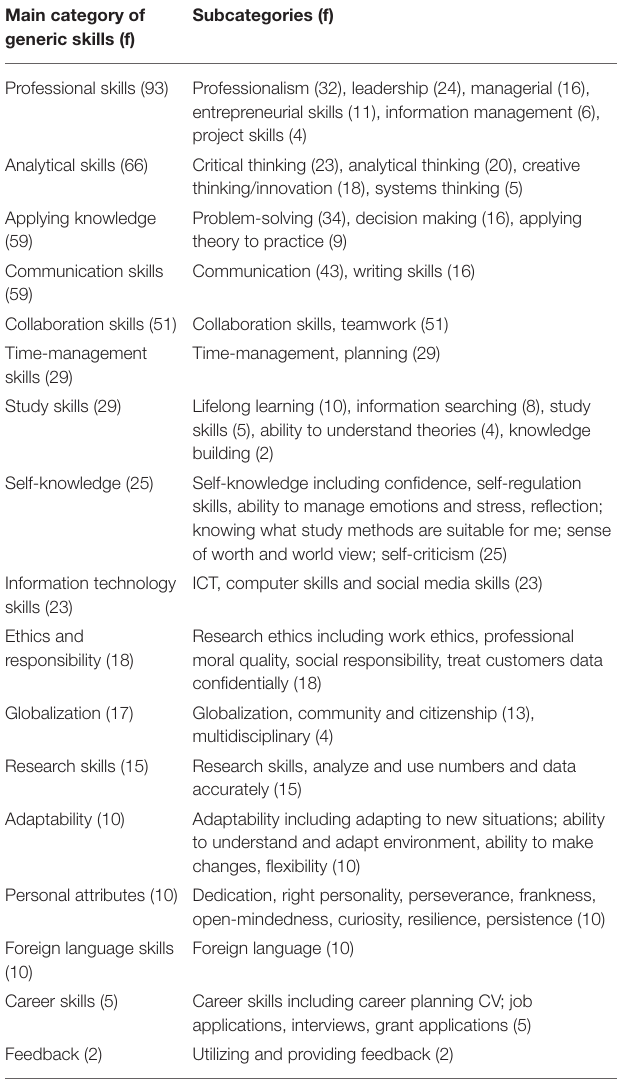
TABLE 2 | Sets of generic skills: the main categories and subcategories of measured generic skills. Main category of generic skills